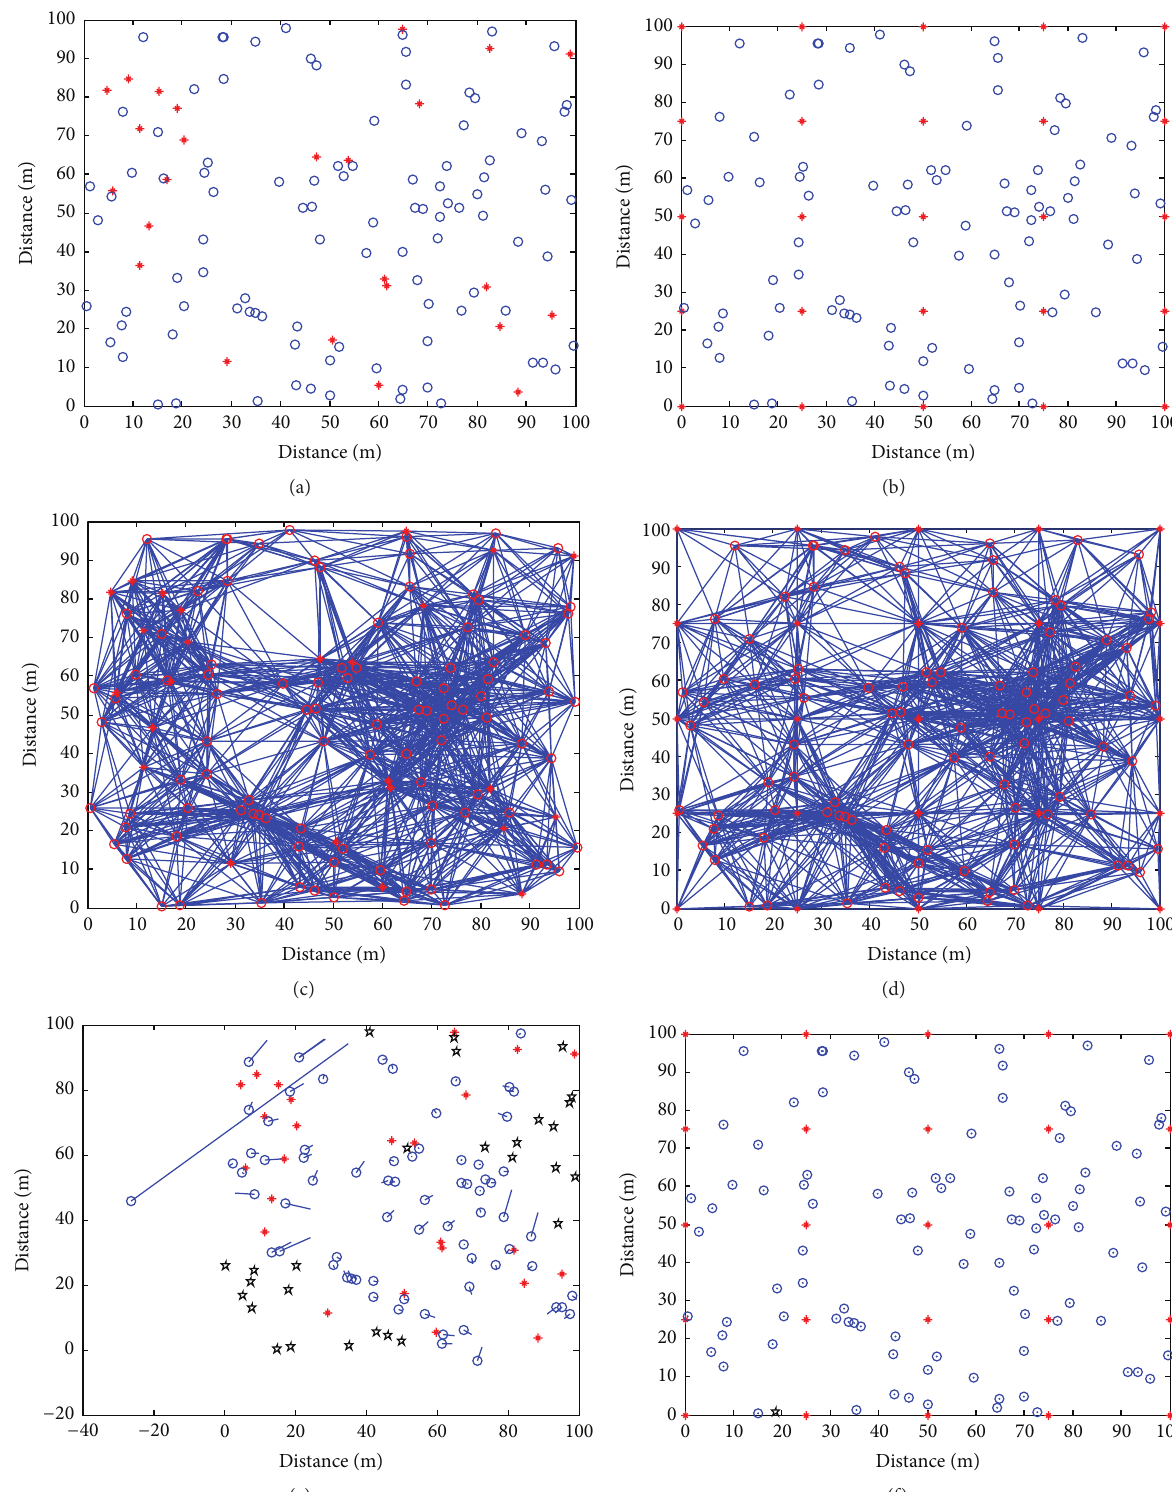
Figure 8: Connectivity and localization effect ((a) and (b) are the node deployment; (c) and (d) are the neighbor relationship of nodes; (e) and (f) are the localization error, in conditions of random deployment and grid scan,